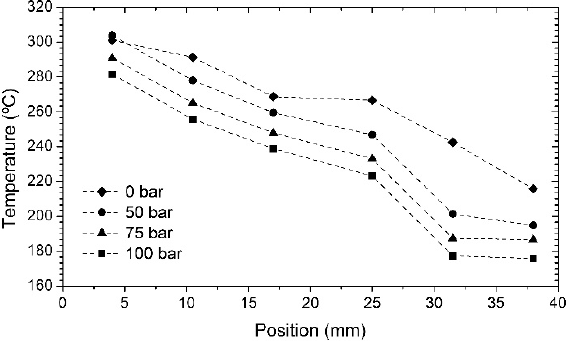
Figure 8. Temperature profile for the bonded (A.B.) configuration with varying compression pressures.